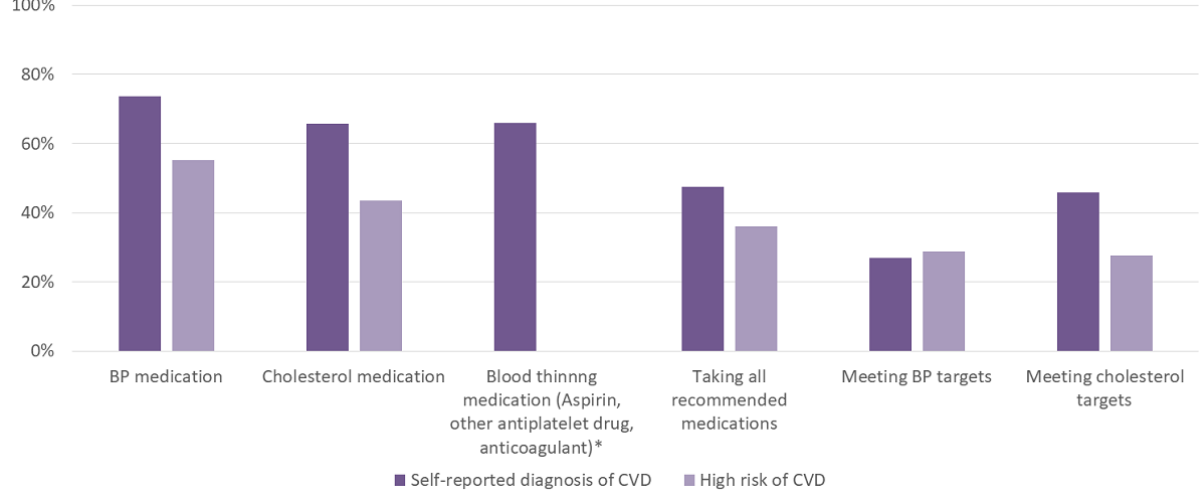
Figure 1. Management for people with or at high risk of CVD (n=231). BP: blood pressure; CVD: cardiovascular